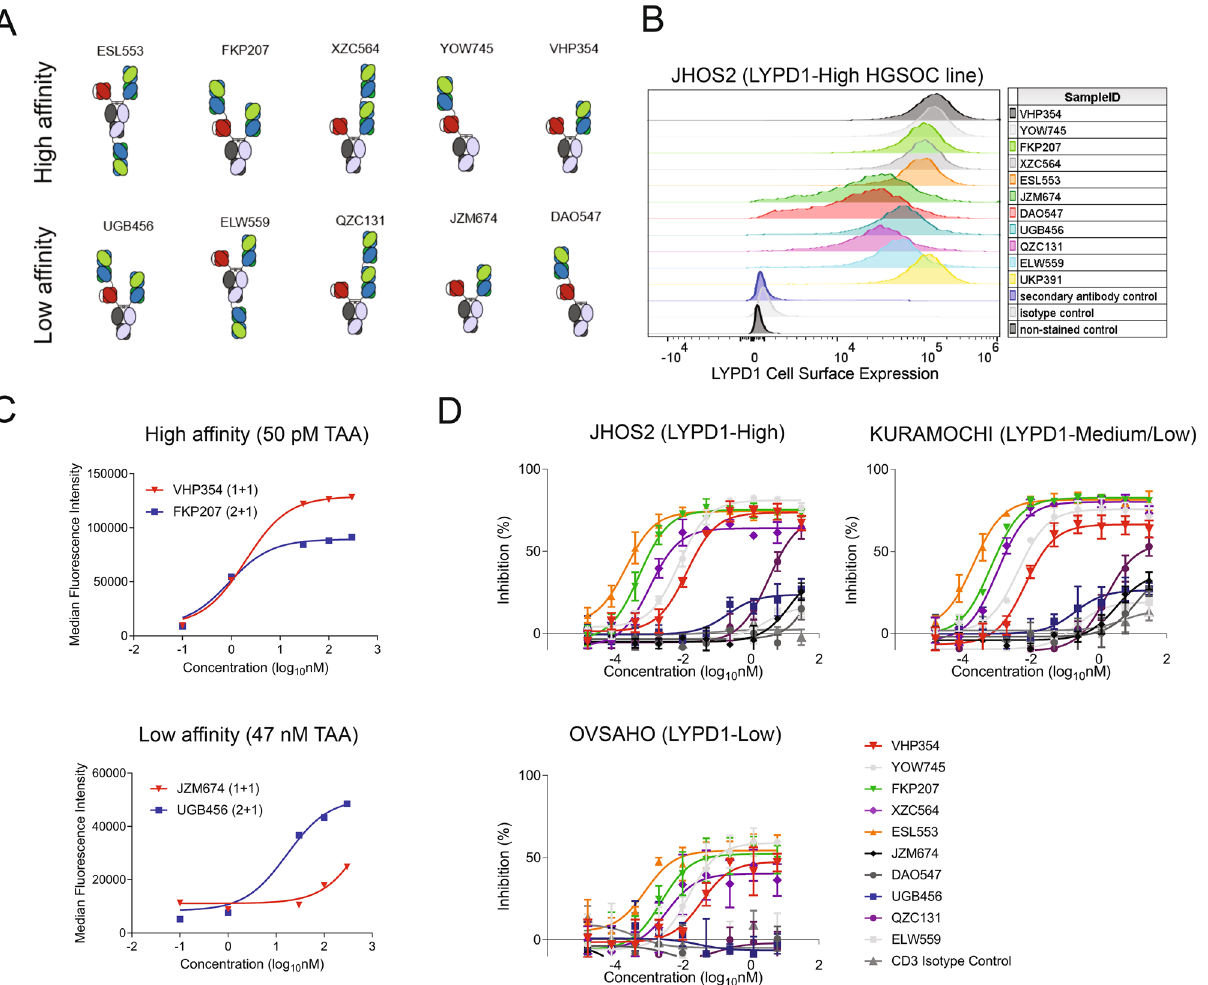
Figure 2. LYPD1-directed TCBs activate T cells to induce target-dependent T cell-mediated cytotoxicity. ( A ) Schematic of LYPD1-directed TCBs with two low-affinity (47 nM) bivalent anti-LYPD1 Fab arms (green) and one anti-CD3 scFv (red), termed 2 + 1 TCB, or one high affinity (50 pM) monovalent anti-LYPD1 fab arm and one anti-CD3 scFv, termed 1 + 1 TCB, across multiple TCB geometries. ( B ) FACS histograms demonstrate LYPD1-specific binding across all formats on the ovarian cancer cell line JHOS2. ( C ) FACS titration curves show dose-dependent binding to JHOS2 for LYPD1-monovalent 1 + 1 TCB (red) and LYPD1-bivalent 2 + 1 TCB (blue) with no change in the FACS EC50 for high affinity binders but 30-fold improved binding for low affinity binders. ( D ) LYPD1-directed TCBs with high affinity TAA demonstrate selective and dose-dependent induction of T cell-mediated cytotoxicity across all cell lines regardless of antigen density, while LYPD1-bivalent 2 + 1 TCBs with low affinity induce T cell-mediated cytotoxicity only in the high (JHOS2) and medium/low (KURAMOCHI) antigen density cell lines and spare the LYPD1-low expressing cell line OVSAHO. 10-point dose response curves from a starting concentration of 30 nM demonstrate activity differentials across